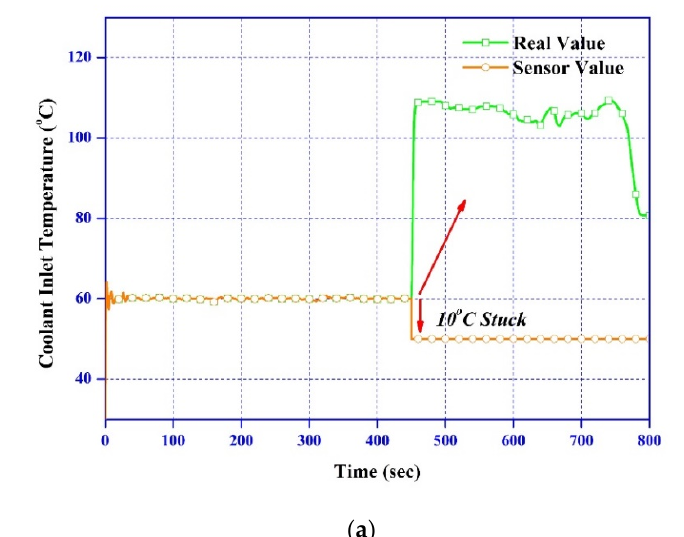
Figure 7. Sensor measurements, residuals and detection results in the stack stuck fault of HWFET driving cycle (( a )—stack temperature values, ( b )—Coolant inlet temperature value, ( c )—residual from the stack sensor, ( d )—residual from the coolant inlet temperature, ( e )—Cumulative sum (CUSUM) result from the stack temperature sensor, ( f )—CUSUM result from the coolant